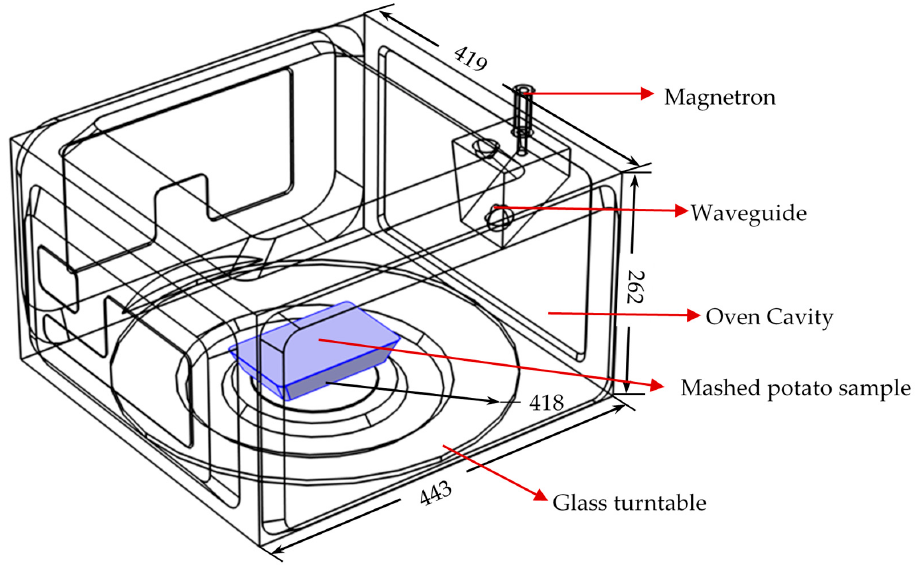
Figure 1. Geometric model of microwave oven and mashed potato in the mechanistic-modeling. (Unit: mm).